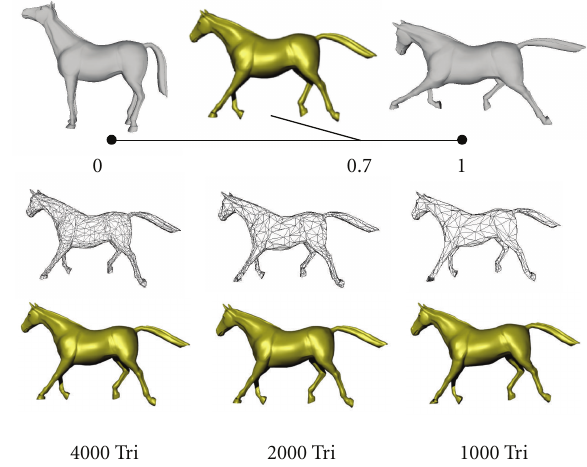
Figure 17: Interpolation results using coarse meshes. We perform interpolation on several mesh resolutions. Top: interpolation of the original model (17k triangles). Middle: the interpolation results of coarse meshes (4k, 2k and 1k triangles). Bottom: comparison of the dense results. The results are nearly identical for all the